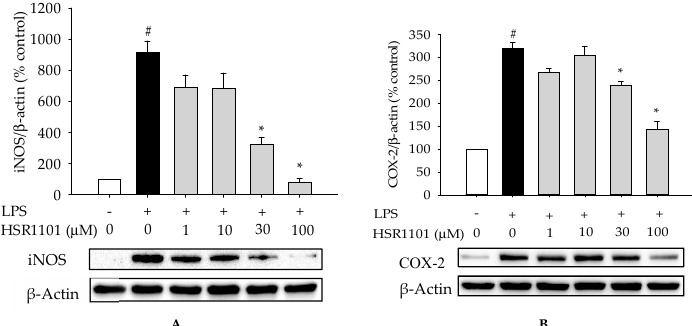
Figure 4. HSR1101 inhibited LPS-induced expression of inducible NO synthase (iNOS) and COX-2 in BV2 cells. BV2 cells were co-treated with 1 µg/mL LPS and a series of concentrations of HSR1101 for 24 h. Western blotting analyses were conducted using anti-iNOS ( A ) and anti-COX-2 ( B ) antibodies, as described in the Materials and methods section. β -Actin was used for normalizing iNOS and COX-2. Representative blots are displayed. Data are expressed as mean ± SEM of at least three independent experiments. # p < 0.05 and * p < 0.05 vs the vehicle-treated control and LPS-treated groups, respectively. LPS, lipopolysaccharide; iNOS, inducible nitric oxide synthase; COX-2, cyclooxygenase-2. Int. J. Mol. Sci. 2020 , 21 , x FOR PEER REVIEW